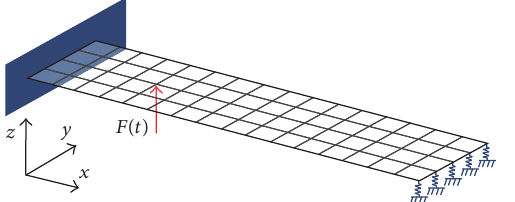
Figure 7: One end clamped and the other end with vertically hardening spring restraints.